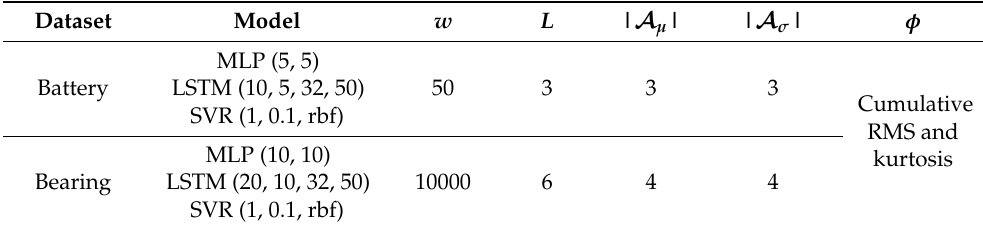
Table 5. Hyper parameters for each experiment.